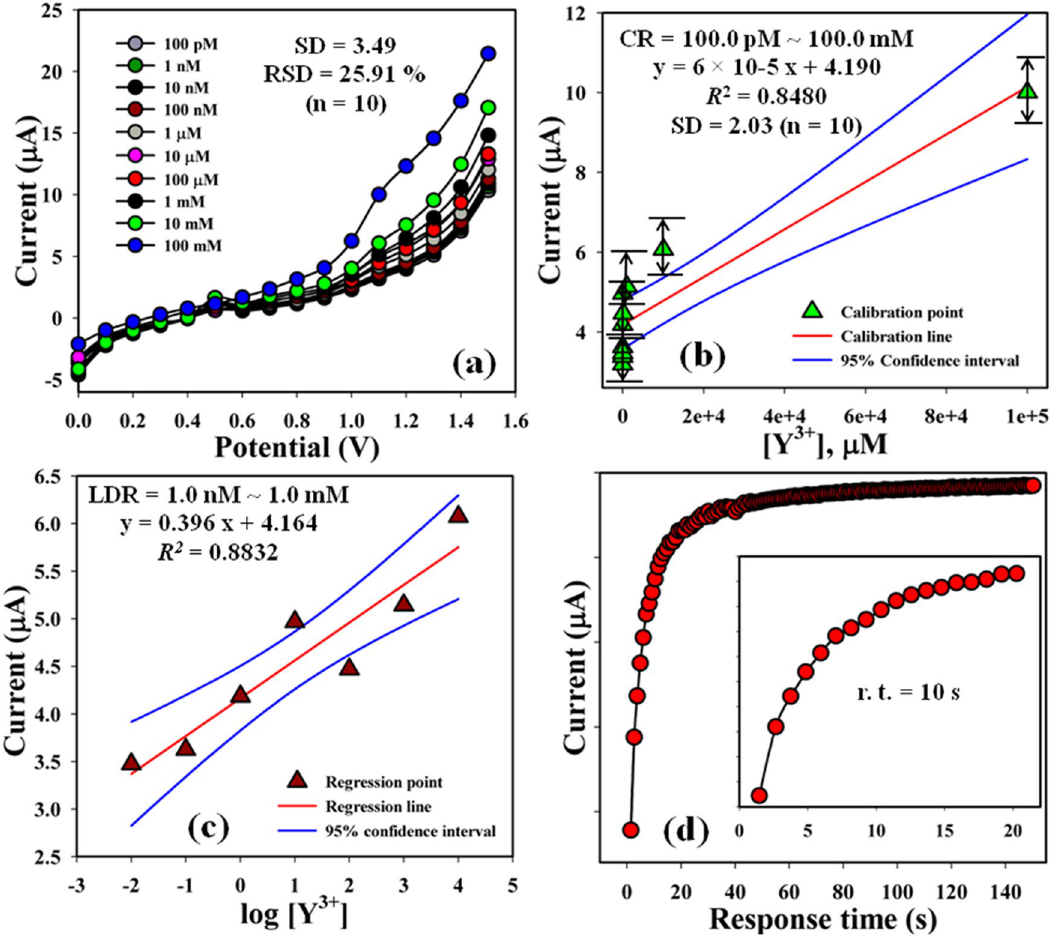
Figure 8. ( a ) Concentration variation, ( b ) Calibration curve at + 1.1 V, ( c ) LDR graph, and ( d ) Response